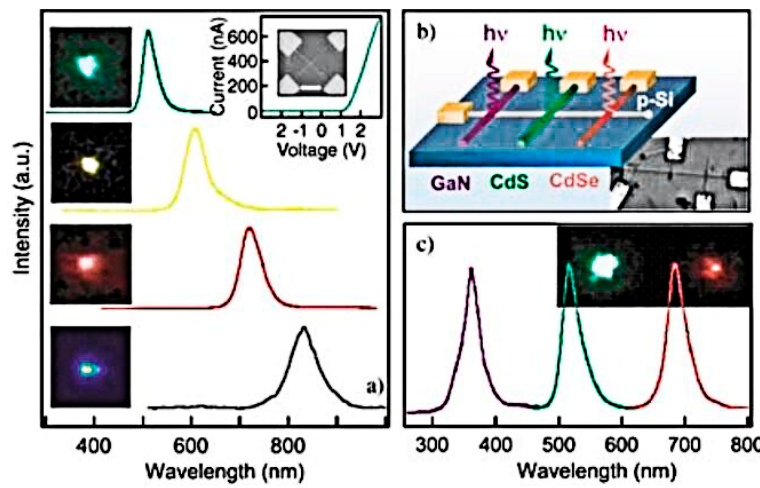
Figure 18. ( a ) EL spectra from crossed p-n diodes of p-type Si and n-type CdS, CdSSe, CdSe, and InP, respectively (top to bottom). Insets to the left are the corresponding EL images for CdS, CdSSe, CdSe (all color CCD), and InP (liquid-nitrogen-cooled CCD) nanoLEDs. The inset top right shows representative I-V and SEM data recorded for a p-Si/n-CdS crossed nanowire junction (scale bar = 1